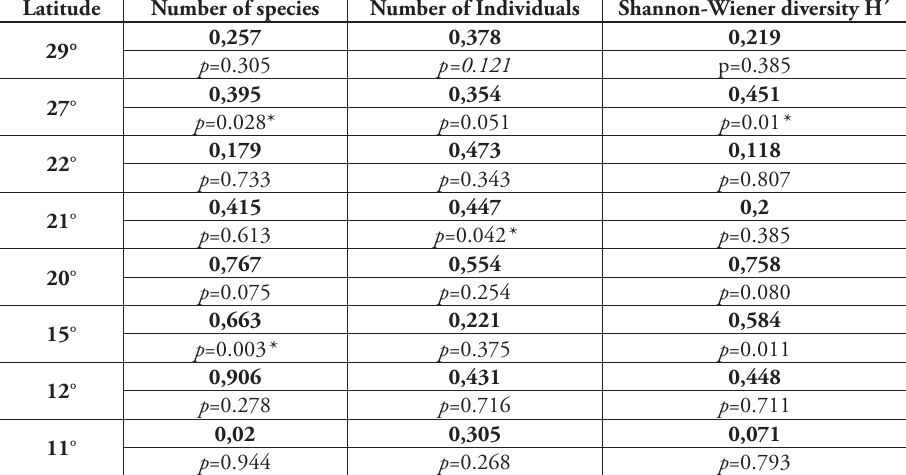
table 5. Regression correlation (r) analysis of fish community pattern vs. hard coral (simple regression); mean fish abundance (N), species richness (number of species) and Shannon-Wiener Index (H`) at reefs at various latitudes along the Red Sea and Gulf of Aden * if p <0.05 significant correlation. Latitude Number of species Number of Individuals Shannon-Wiener diversity H´ 0,219 p=0.121